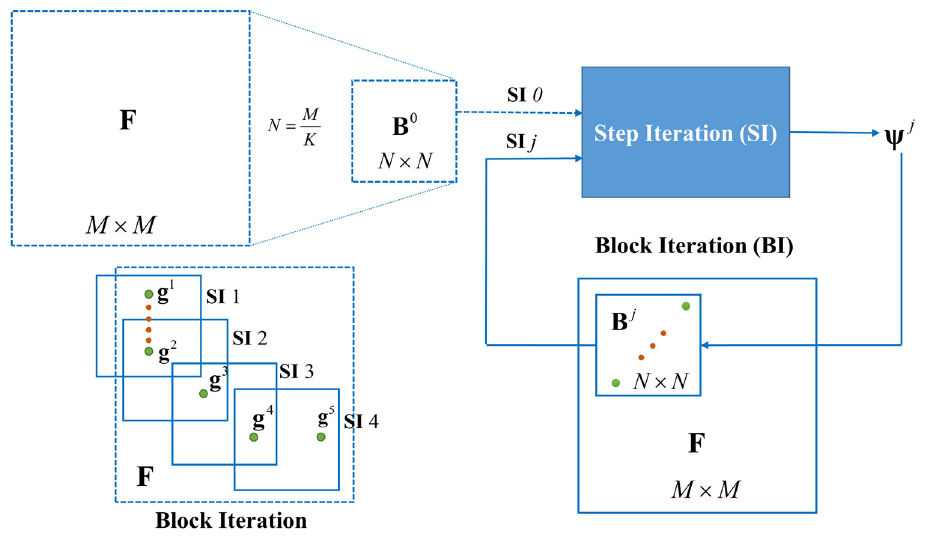
Figure 2. The block iteration framework.